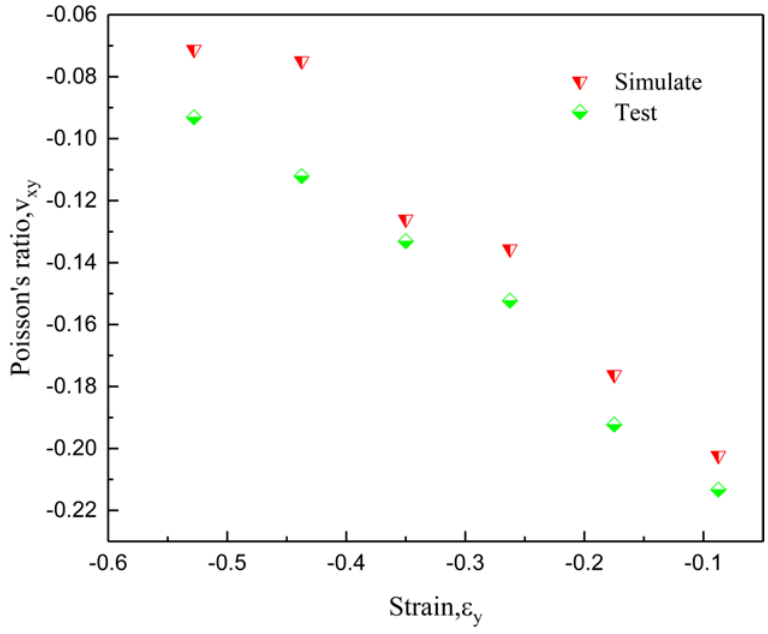
Figure 22. The comparison of Poisson’s ratio–strain curves for experiment and simulation.